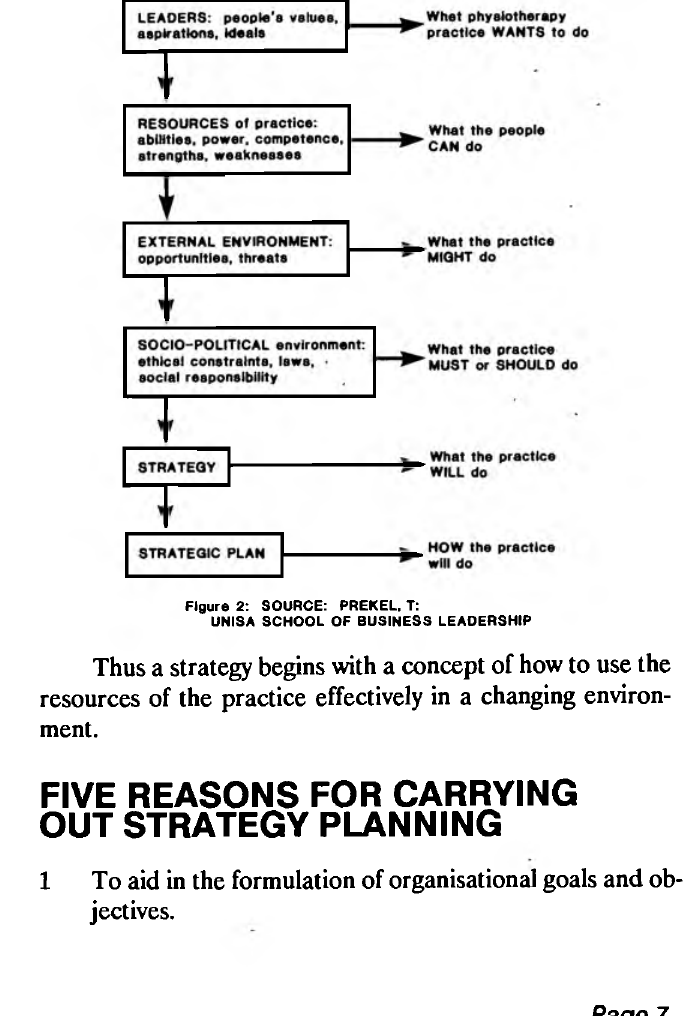
organisation’s or practice’s